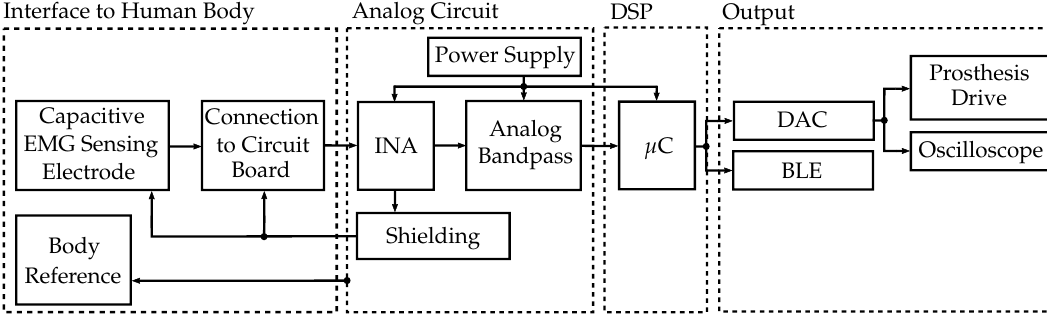
Figure 2. Block diagram outlining the insulated EMG measurement system. The capacitive EMG sensing electrode is connected to the analog circuit, where it is preamplified and filtered. The analog circuit provides shielding and a body reference. Digital signal processing (DSP) is performed in the microcontroller ( µ C). The digital-to-analog converter (DAC) is connected to the prosthesis drive in real-world applications. Bluetooth-low-energy (BLE) and an oscilloscope were used in